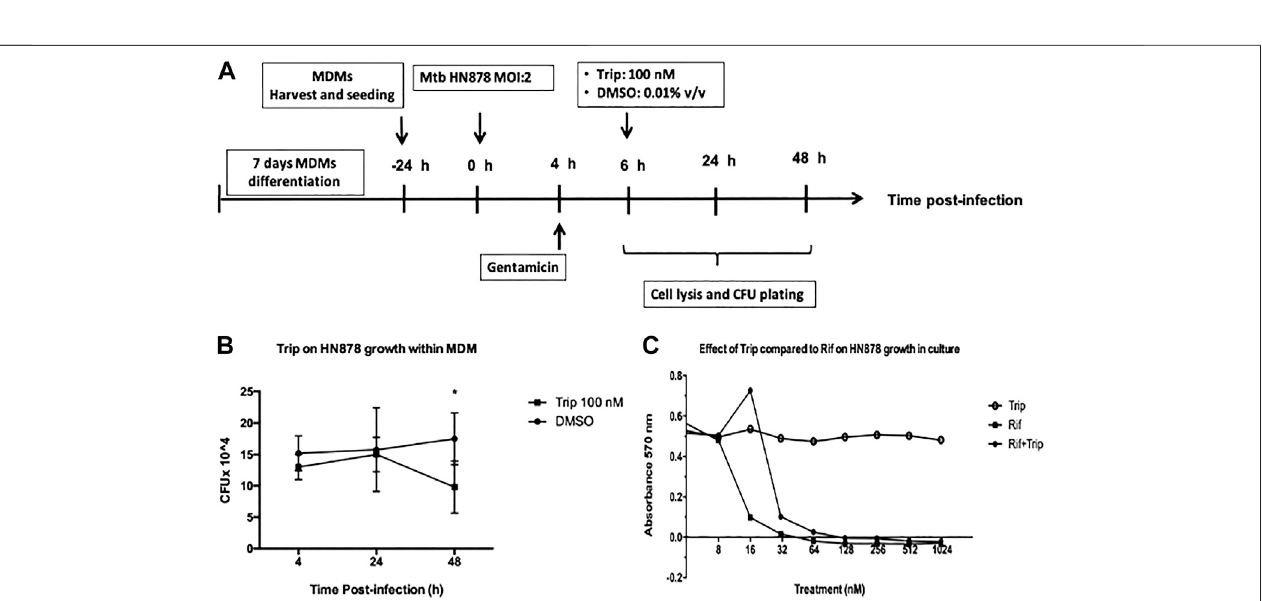
FIGURE 5 | Triptolide treatment decreases Mtb HN878 growth in MDMs but not in the culture medium. (A) : Graphical summary for the experiment on the effect of triptolide on Mtb HN878 growth within MDMs. Triptolide reduces Mtb HN878 CFU in MDMs (B) : 10 ^ 5 MDMs were infected with Mtb HN878 MOI:2 for 4 h then treated with100 nMtriptolidefor24and48 h.DMSOwasusedasvectorcontrol.Ateachtimepoint,BMDMswerelysedandthelysateplatedfordeterminationofCFU15 days later. Triptolide does not affect Mtb HN878 growth in culture medium (C) : 2 × 10 ^ 5 Mtb HN878 CFU was seeded on 96-well plates and then treated with triptolide, rifampicin, or mixtures of both at different concentrations. DMSO was used as a vector control. alamarBlue stain was added to the plate on day 14 and OD was read at 570 nm * p < 0.05; ** p < 0.01; *** p < 0.001.